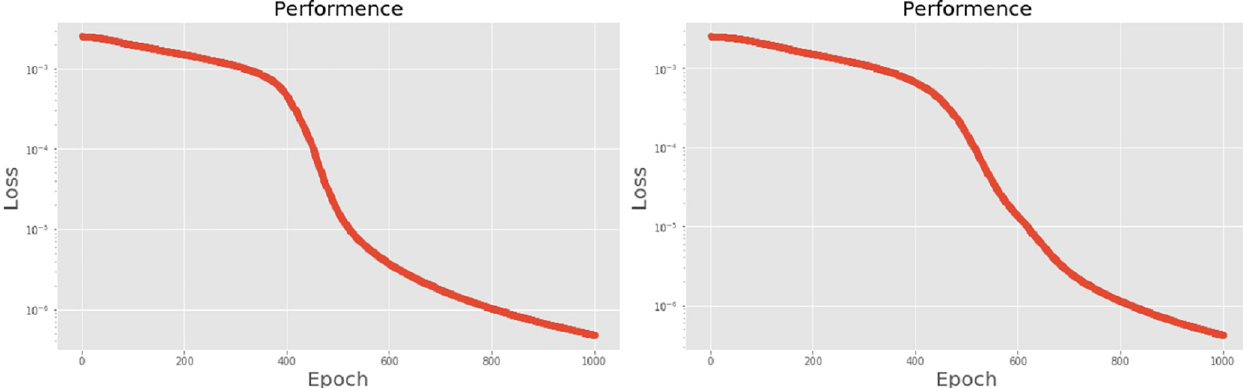
Fig 19. (a) The graph shows the performance of MFCC-DNN-20-layer model; (b) The graph shows the performance of MFCC-PCA-DNN-20-layer model.